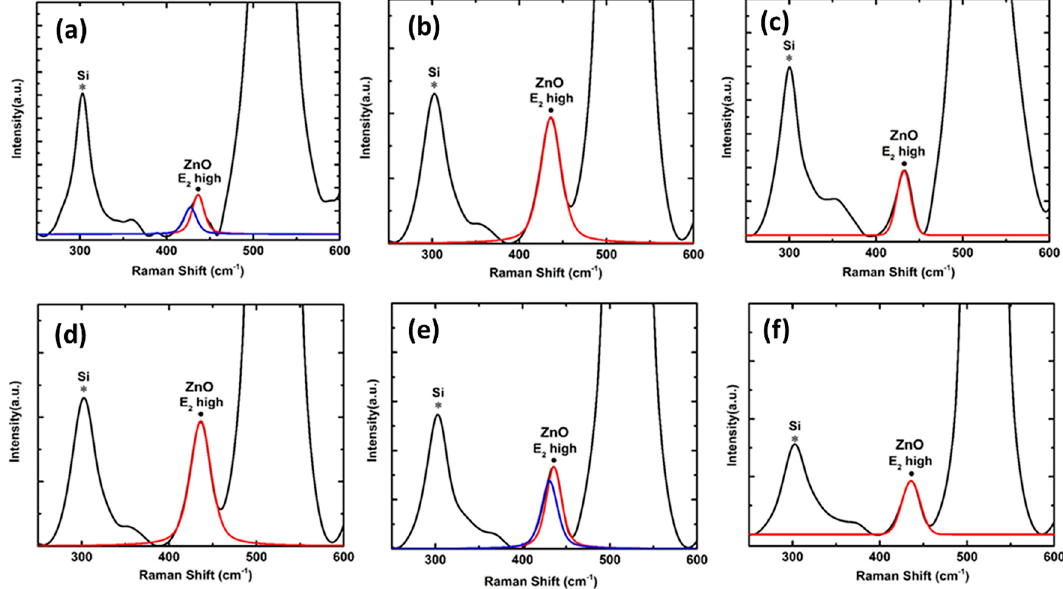
Figure 3. Raman spectra of ZnO nanorods at different temperatures ( a ) 500 °C, ( b ) 550 °C, ( c ) 600 °C and Raman spectra of ZnO nanorods grown at 550 °C by varying the number of pulsed laser shots ( d ) 5000, ( e ) 10,000, ( f ) 15,000.